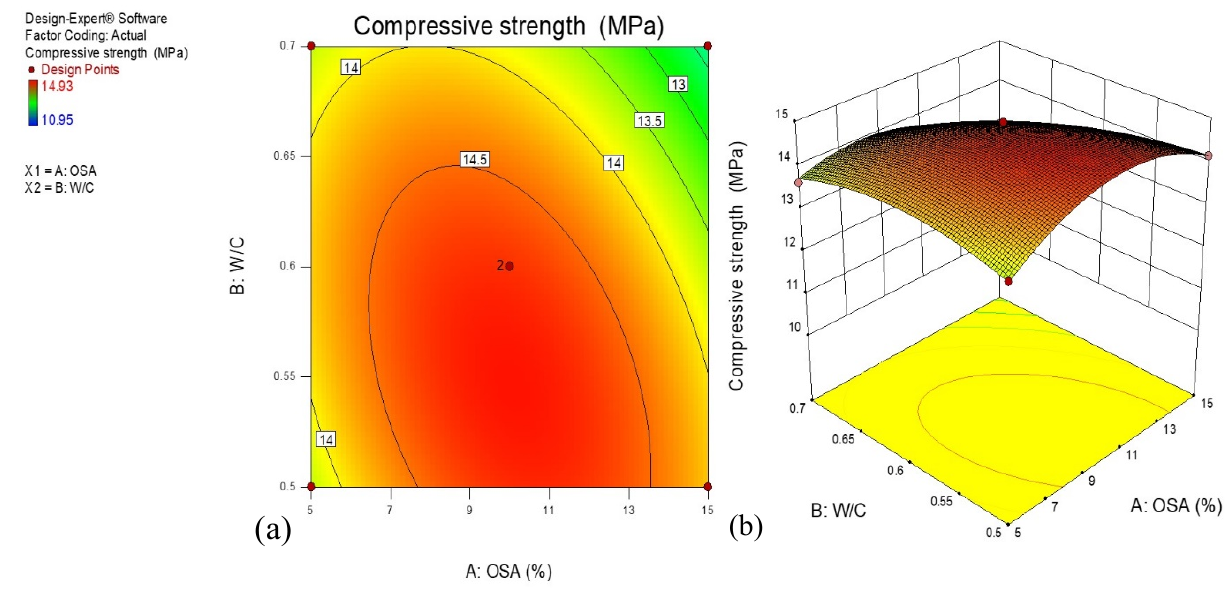
Figure 6. ( a ) 2-D and ( b ) 3-D plots for compressive strength development of cement-based mortar.